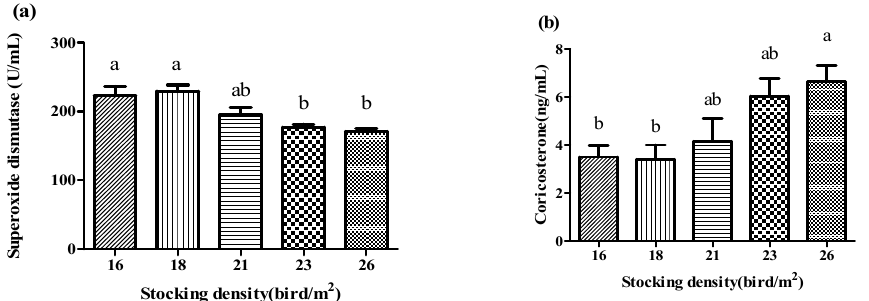
Figure 1. Effect of stocking density on superoxide dismutase ( SOD) activity ( a ) and corticosterone ( b ) in the blood of broiler chickens under high temperatures ( n = 15). SOD activity: linear, p < 0.001; quadratic, p = 0.800. Corticosterone: linear, p < 0.001; quadratic, p = 0.344. Bars with different letters (a,b) differ significantly across all groups ( p < 0.05).